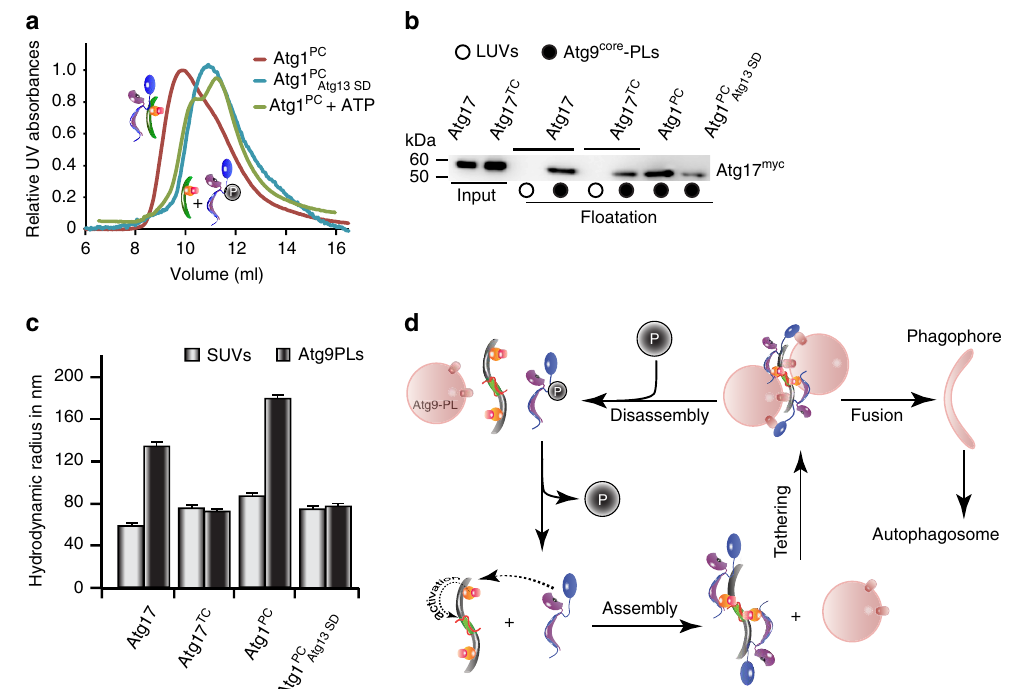
Figure 7 | Phosphorylation of Atg13 disassembles Atg1 PC and prevents tethering. ( a ) SEC elution profiles of Atg17 TC in the presence of Atg1–Atg13 (red), Atg1–Atg13 SD (blue), and Atg1–Atg13 þ ATP (green). Atg13 SD and addition of ATP prevents assembly of Atg1 PC . ( b ) a -myc immunoblot of co-floatation experiments of Atg9–PLs with recombinant myc-tagged Atg17 and Atg17 TC without and with Atg1–Atg13 (Atg1 PC ) or Atg1–Atg13 SD (ref. 23). Similar experiments with large unilamellar vesicles (LUVs) lacking Atg9 core served as controls. Input corresponds to 10% of total protein used for co-floatation. ( c ) The hydrodynamic radius of SUVs (white bar) and Atg9–PLs (black bar) with similar samples as shown in ( b ) obtained from DLS-experiments. Mean values ± s.d. of N ¼ 5 experiments. ( d ) Model for Atg1 PC function, tethering of Atg9-vesicles, and its regulated assembly from and disassembly into subcomplexes. P indicates phosphorylation of Atg13 under vegetative conditions. NATURE COMMUNICATIONS|7:10338|DOI: